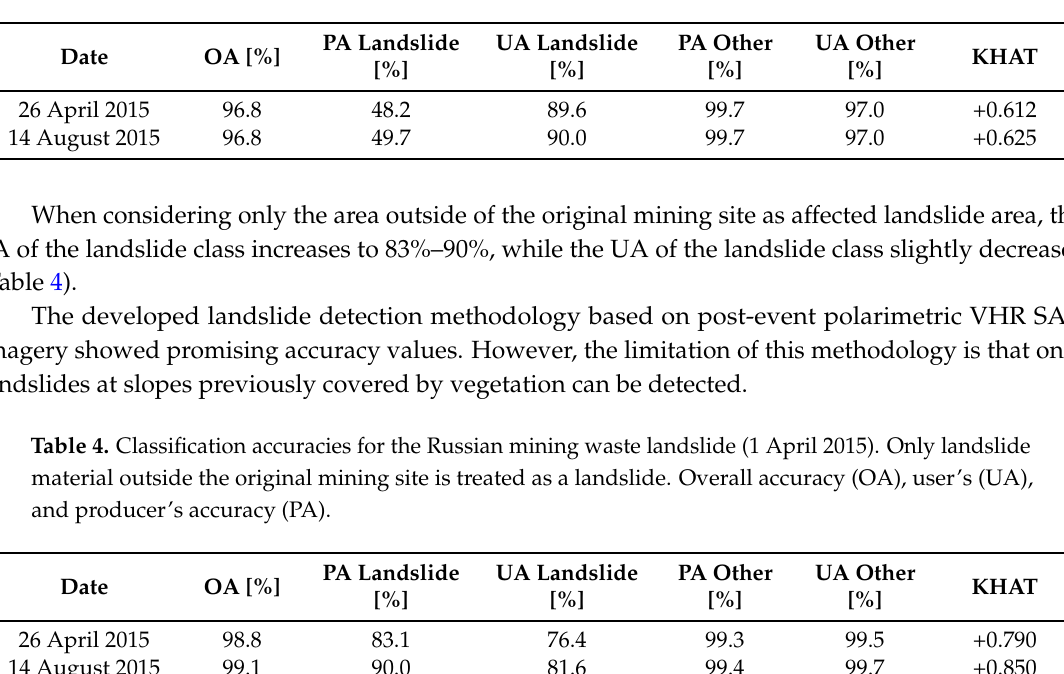
Table 3. Classification accuracies for the Russian mining waste landslide (01 April 2015). Overall